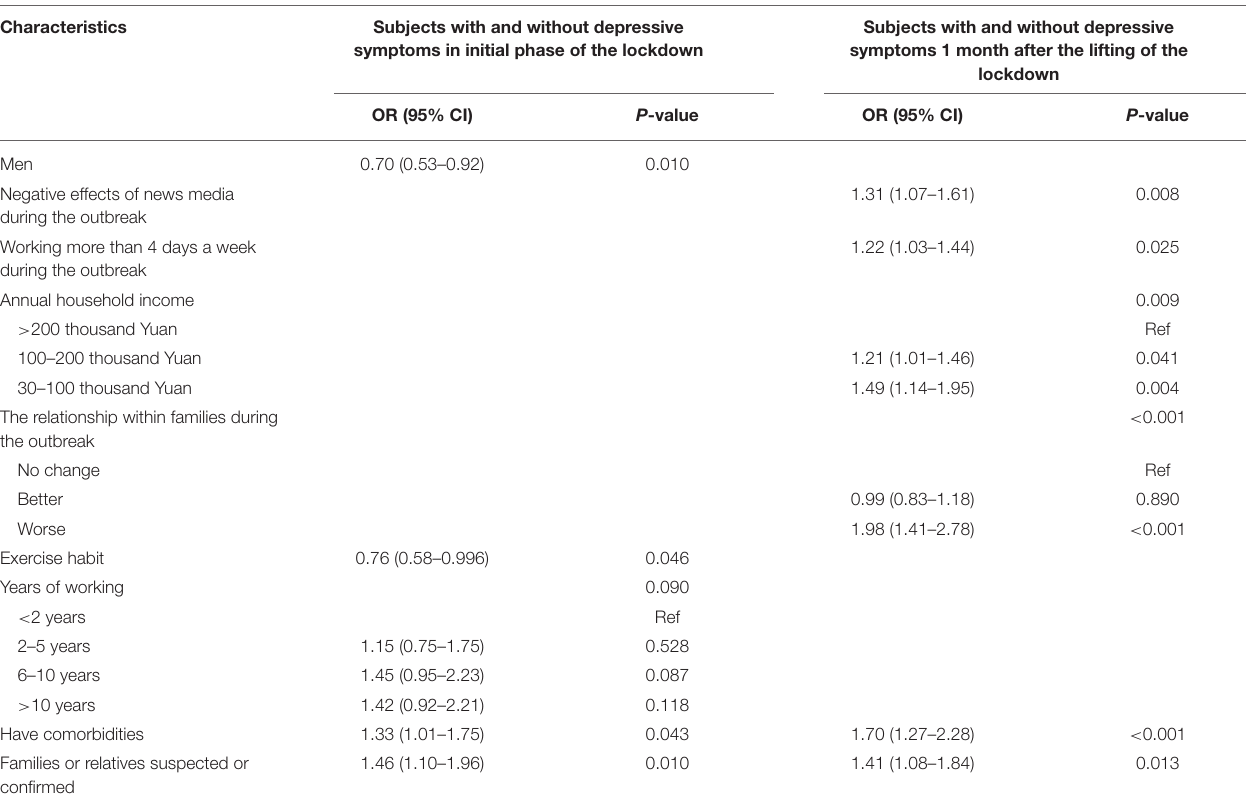
TABLE 4 | Factors associated with depressive symptoms for front-line HWs in two phases of COVID-19. Characteristics Subjects with and without depressive symptoms in initial phase of the lockdown